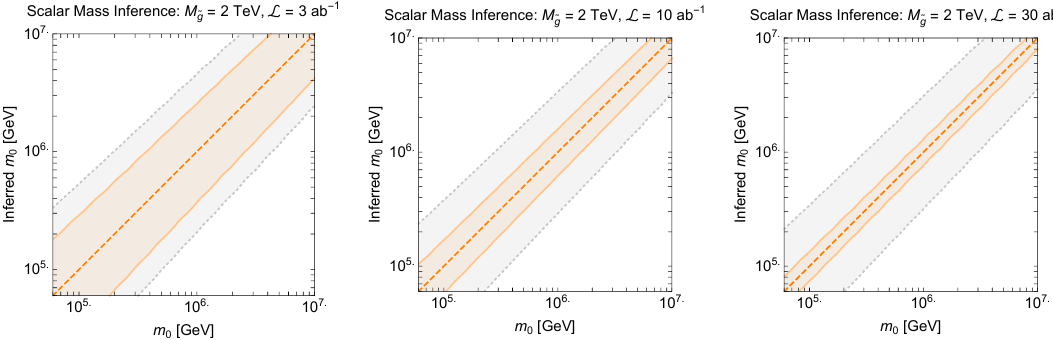
Figure 10 . Inference of the scalar mass scale m 0 from the measurement of the rate of 2-body decays ! g e H 0 . The parameters are M e g 3 = 2 TeV, (cid:22) = 400 GeV, M 1 = 200 GeV, and M 2 = 800 GeV. The orange band represents 1 (cid:27) statistical uncertainty with 3 ab (cid:0) 1 of data (left), 10 ab (cid:0) 1 of data (middle) and 30 ab (cid:0) 1 of data (right), while the grey band corresponds to a 3% systematic uncertainty on cut e(cid:14)ciencies times cross section times